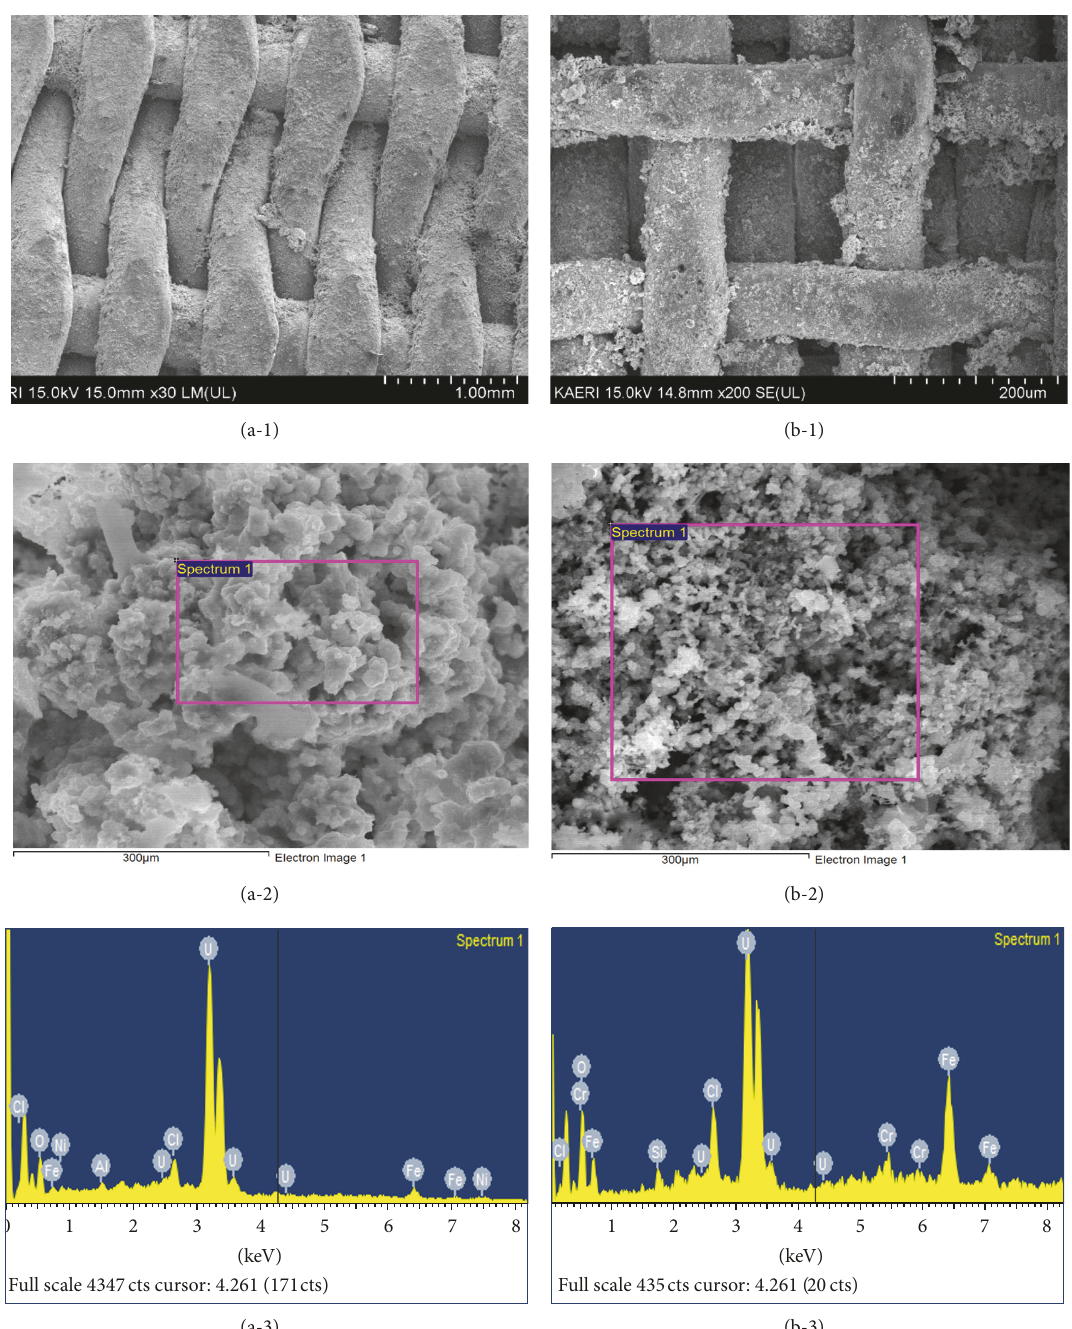
Figure 7: Analysis of the cathode basket after the second OR and the subsequent fuel separation via salt draining: (a-1) SEM image of its inner 16 mesh ( × 30), (a-2) SEM image of the remaining particles on the inner 16 mesh ( × 10,000), (a-3) element identification of the remaining particles using EDX, (b-1) SEM image of its outer 30 mesh ( × 200), (b-2) SEM image of the remaining particles on the outer 30 mesh ( × 10,000), and (b-3) element identification of the remaining particles on the outer mesh using